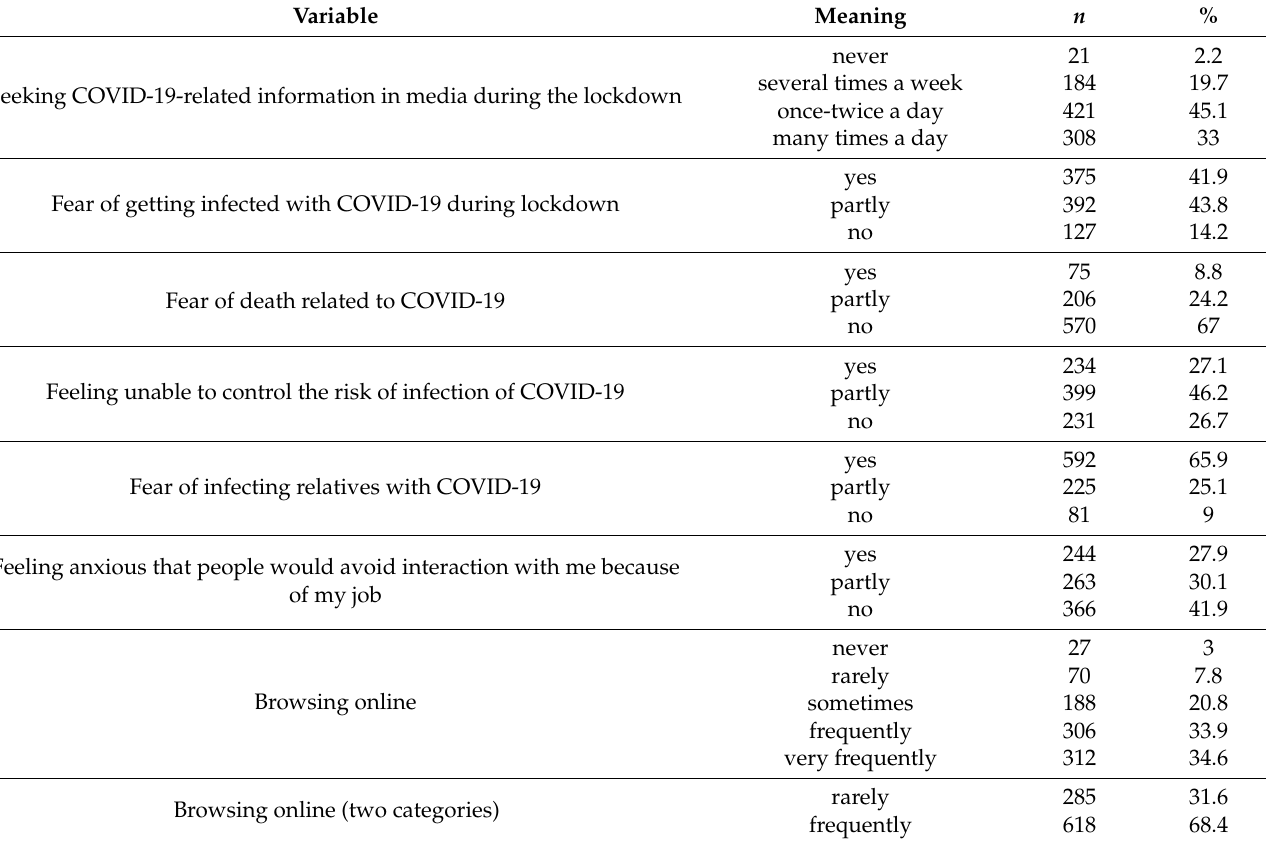
Table 2. COVID-19-Related Information Seeking, Fears and General Browsing: Percentage Distribution. Variable Meaning n